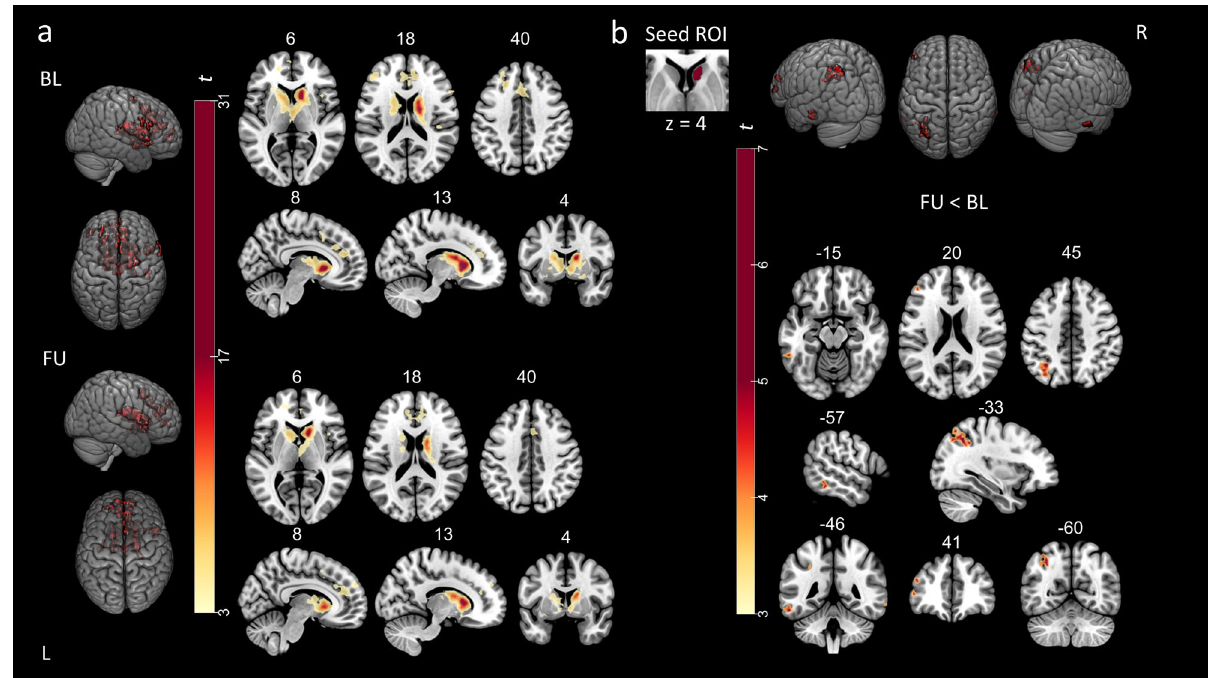
Fig. 5 Direct comparison of caudato-cortical functional connectivity between follow-up and baseline. a Caudatal seed-to-voxel functional connectivity maps of patients with PD at baseline ( top ) and follow-up visit ( bottom ). Scaled colorbar indicates t -values. All results were thresholded at p FWE < 0.05 cluster level. b Signi fi cant differences in caudatal functional connectivity between patients at baseline and follow- up visit. Study-speci fi c seed ROI was provided by the cluster derived from the FDOPA-PET comparison (FU < BL) SPM t -maps are overlaid on a T1 MNI template. All results were thresholded at p FWE < 0.05 or p FDR < 0.05 cluster level, respectively. The numbers above the slices represent MNI x -, y -, or z -coordinates,